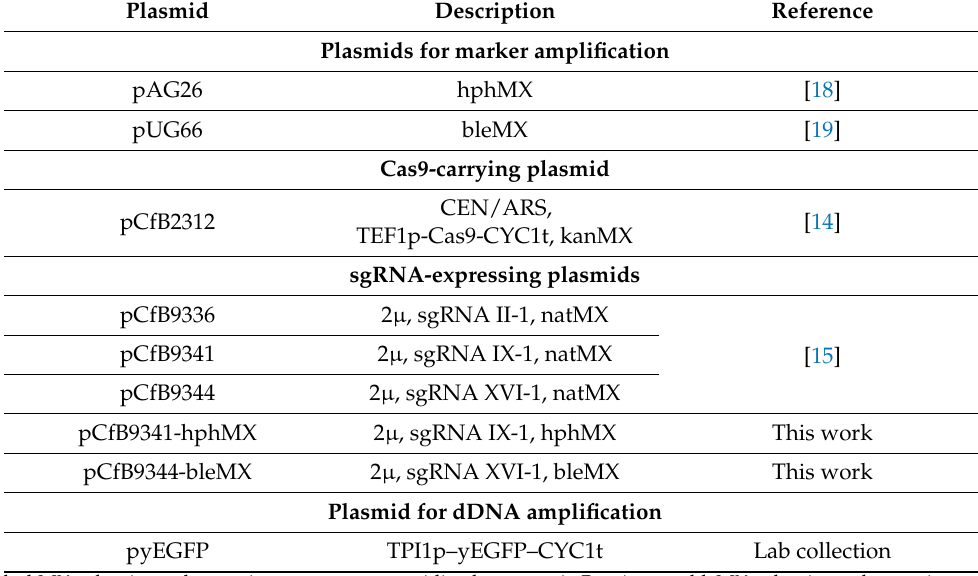
Table 1. List of plasmids used in this